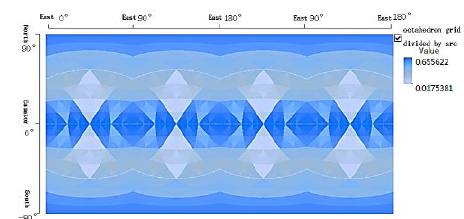
Figure 9. The planar distribution of mean square deviation of major-minor of octahedron grid divided by arc